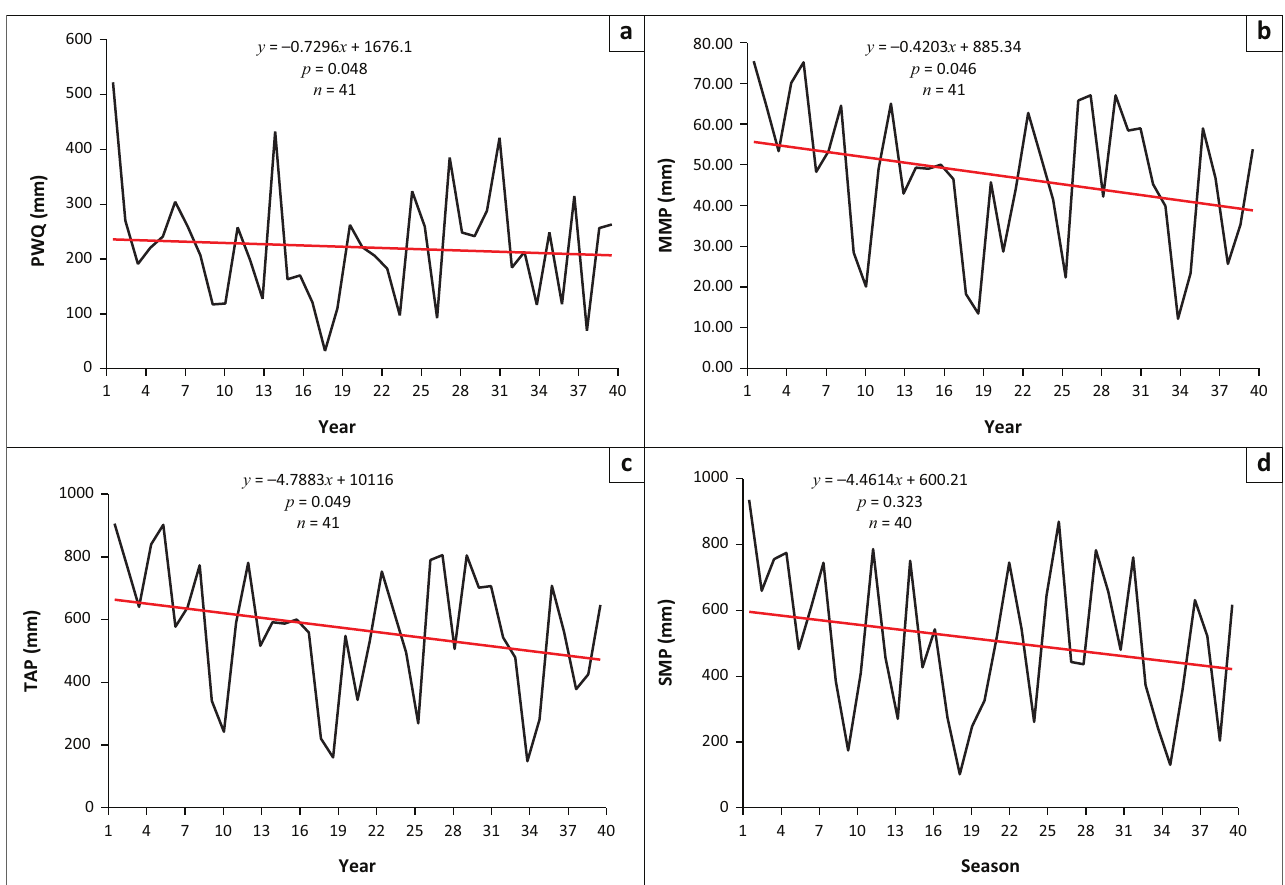
FIGURE 5: Precipitation in Masvingo city between 1974 and 2014: (a) Precipitation in the warmest quarter (PWQ), (b) mean monthly precipitation (MMP), (c) total annual precipitation (TAP) and (d) seasonal mean precipitation (SMP).